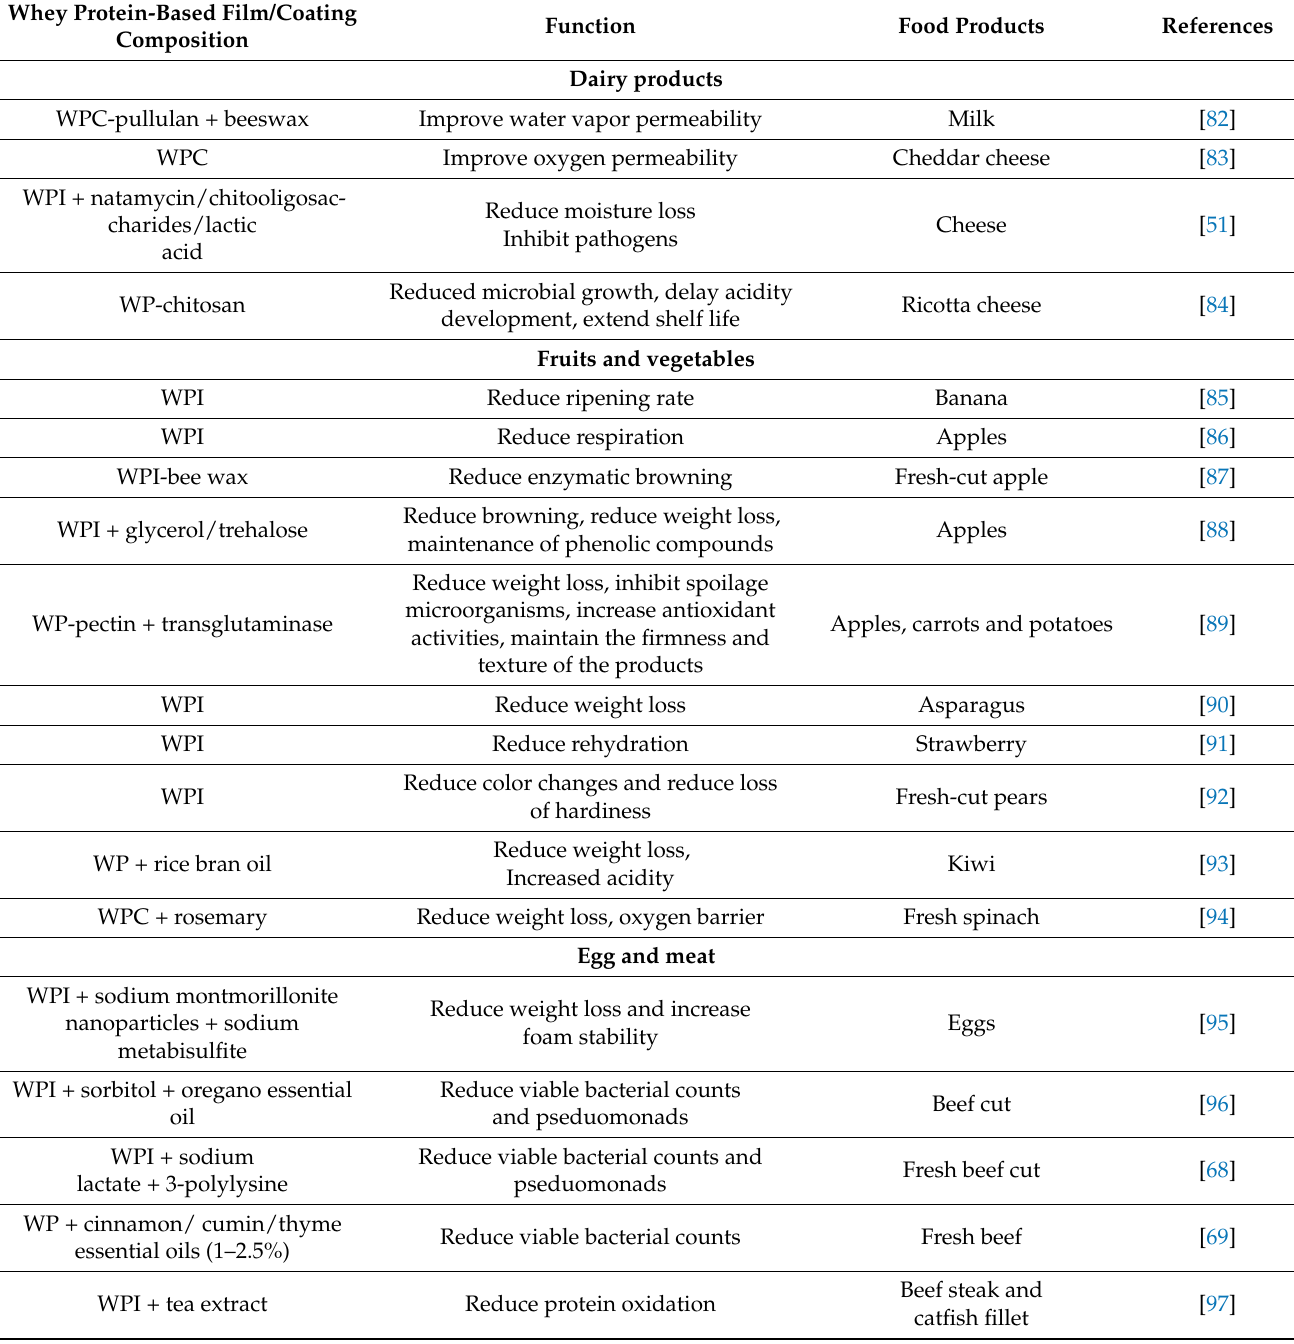
Table 1. An overview on the application of WP-based edible films and coatings on food